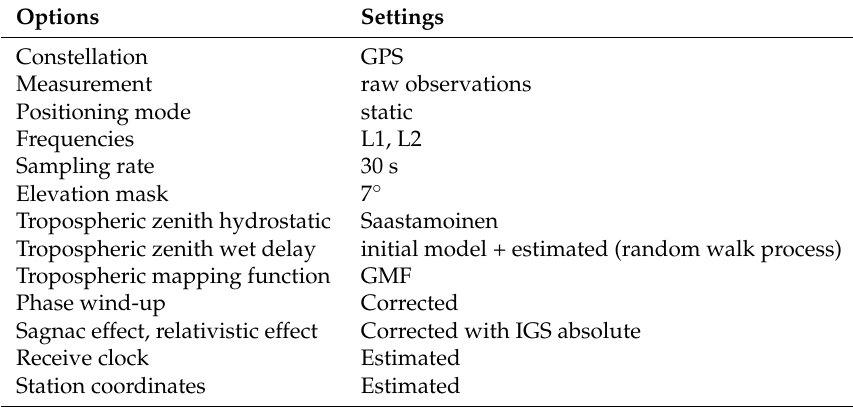
Table 3. Static PPP experimental